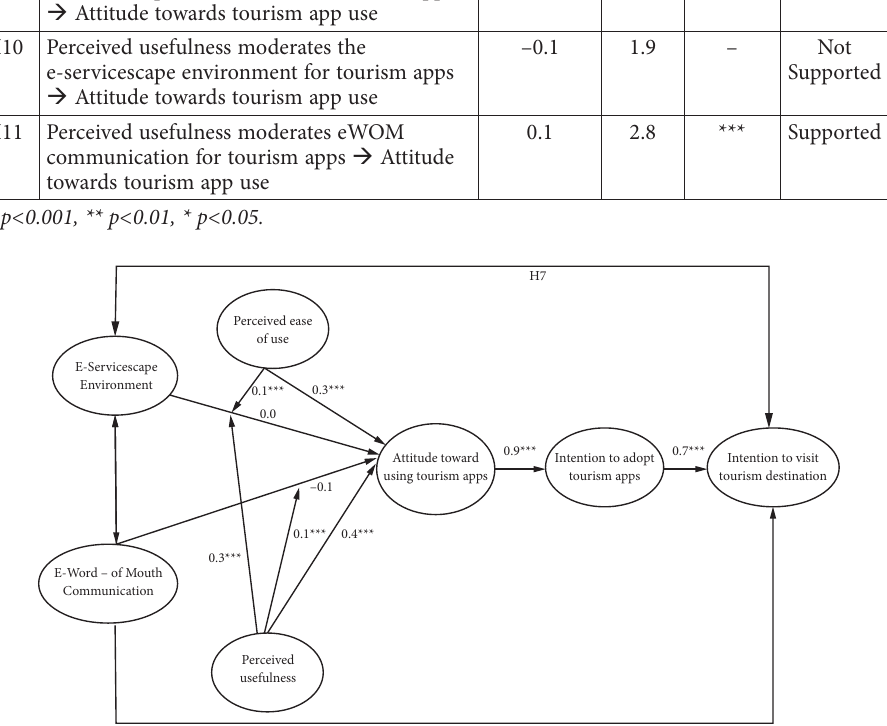
Figure 2. The measurement model of this